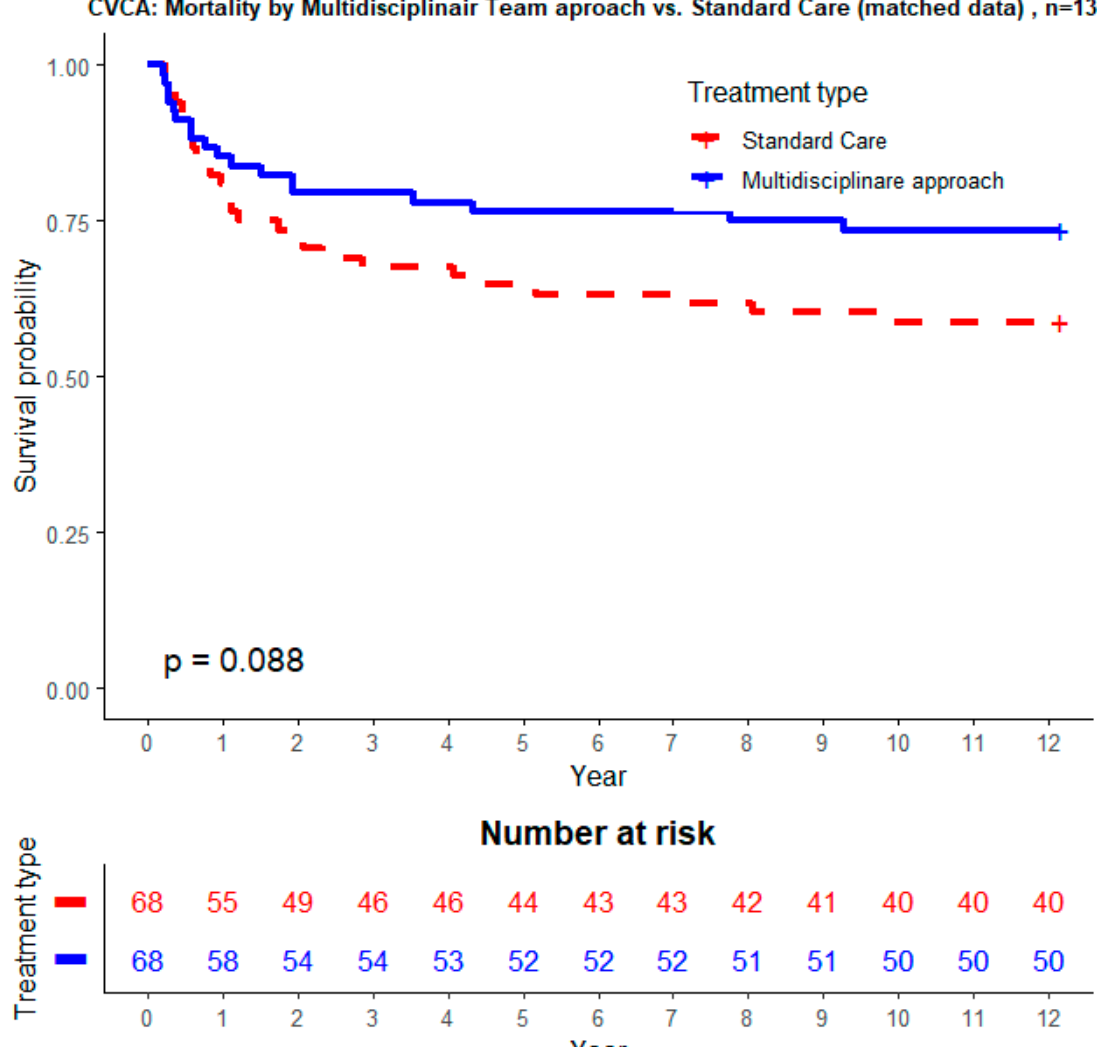
Figure 3. Survival curves of patients entered in the database during 2015 without IEHT compared to the survival curve of patients entered in 2019, while the IEHT was well introduced.